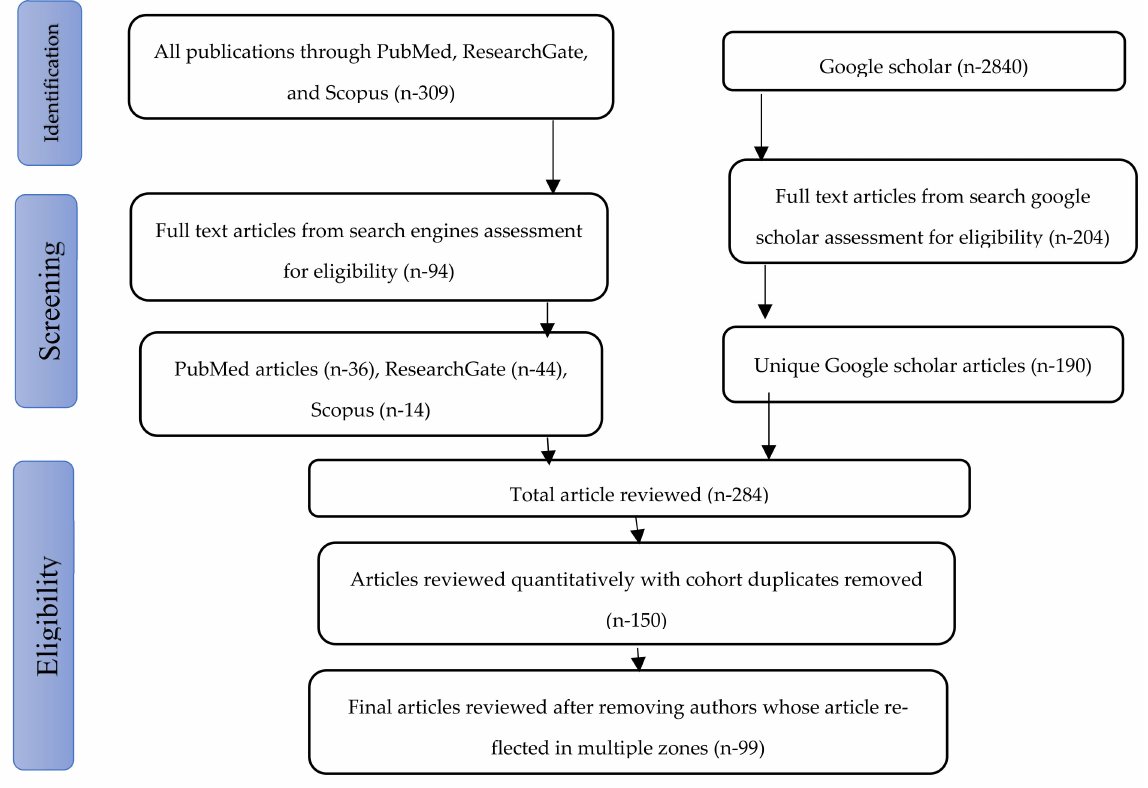
Figure 1. Flowchart of systemic review of human and animal brucellosis for selection of eligible